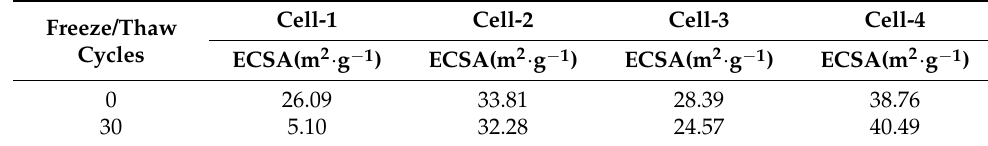
Table 3. The ECSA before and after freeze/thaw cycles.